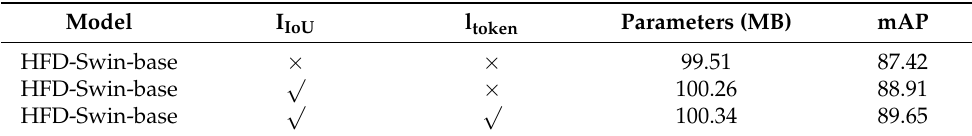
Table 5. Performance change with different loss